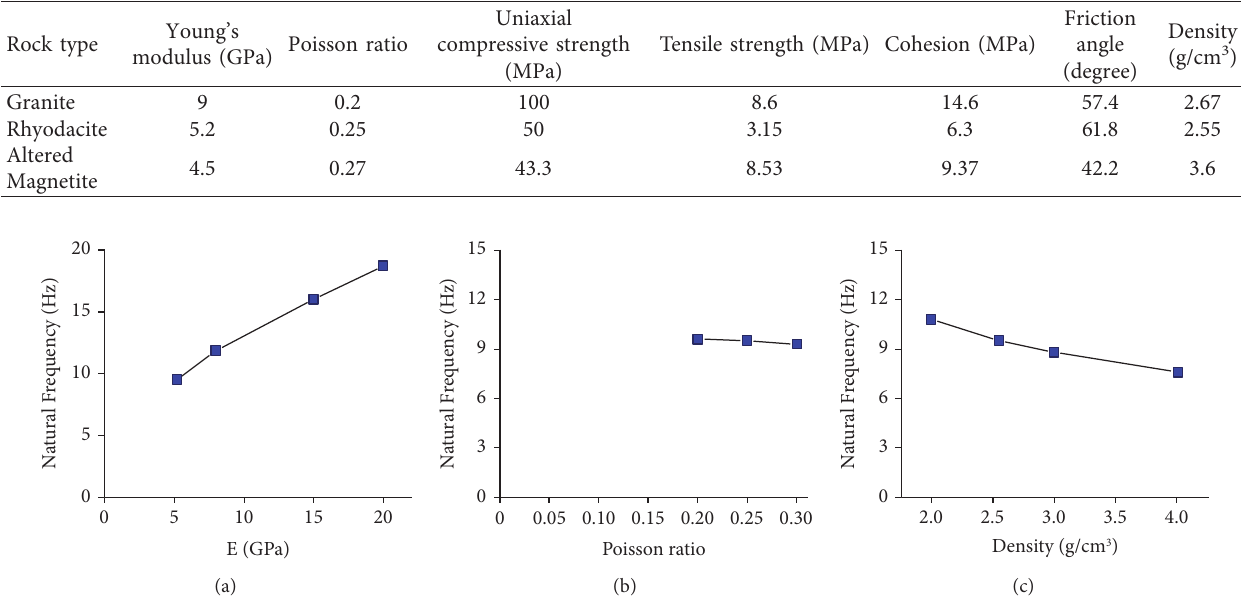
Table 2: The characteristics of three rock samples of the Sangan iron ore mine.